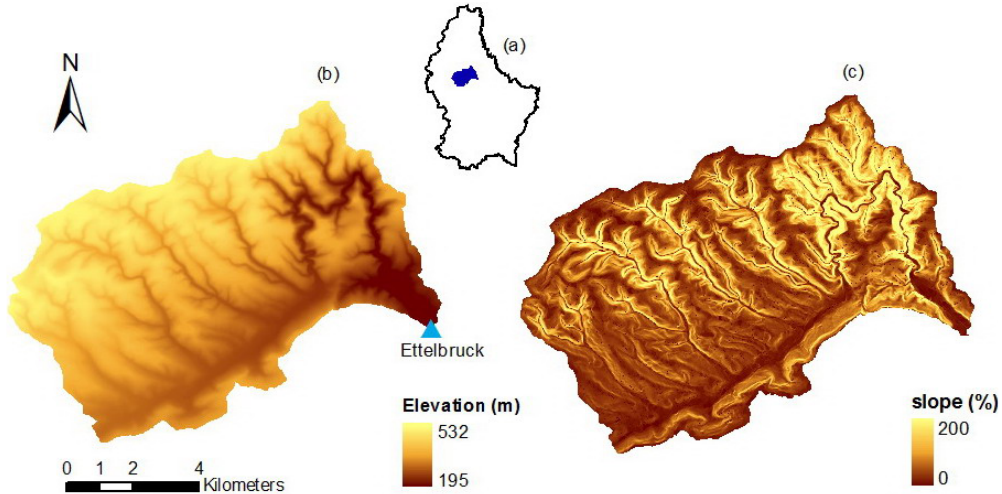
Fig. 1. (a) Location of the Wark Catchment in the Grand Duchy of Luxembourg, (b) digital elevation model (DEM) of the Wark Catchment with cell size of 5m × 5m (m), (c) slope of the Wark Catchment with DEM resolution of 5m × 5m